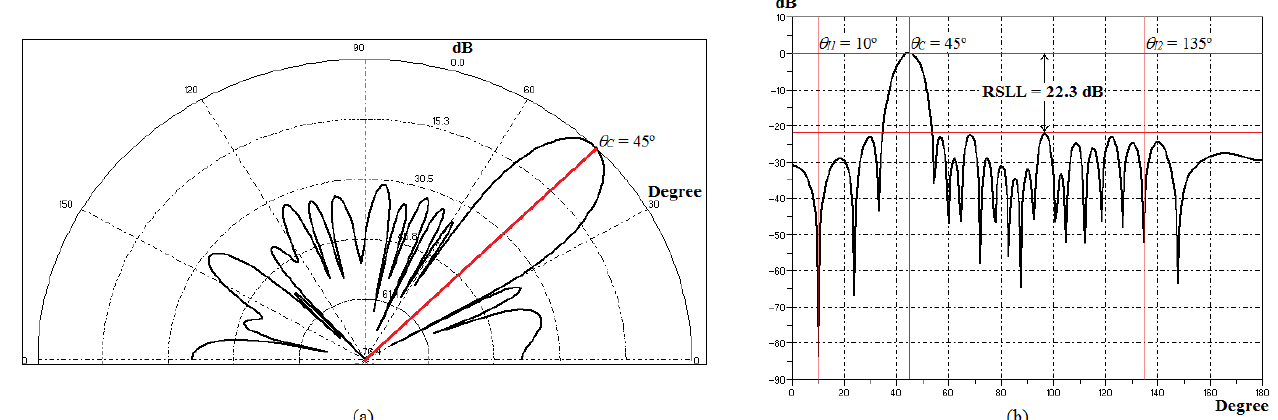
Figure 15. Radiation pattern for θ form. ( b ) Cartesian